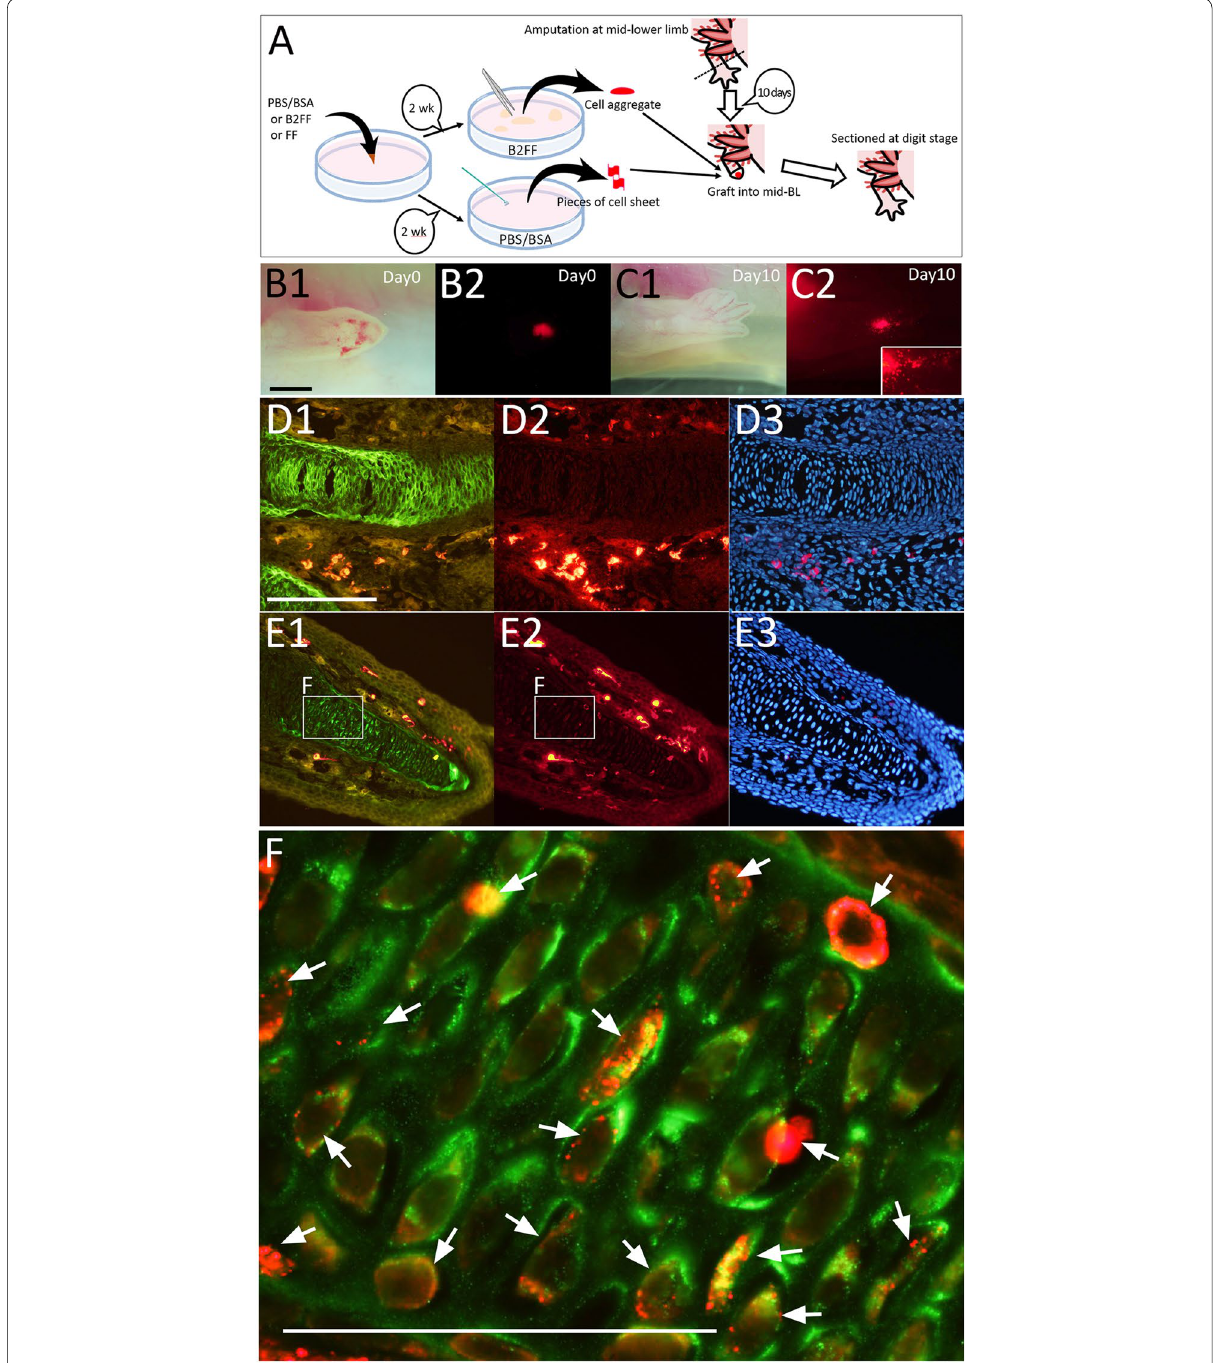
Fig. 2 The cultured newt cells were grafted into regenerating axolotl limb blastema. A The schematic diagram of the experiment. B Just after the grafting. Scale bar in B1 1 mm. C 10 days after the grafting. Newt cells (red) were spread out in the regenerate (insert). D – F The distribution of the = newt cells was investigated on the section. Immunofluorescent analysis for Col2a (green; D1 and E1) and mCherry (red; D2 and E2) was performed. Nuclei were visualized by Hoechst33342 (blue; D3 and E3). F the merged image of the boxed region in E1 and E2. The red signals were observable within the Col2a region. The scales bar in D1 and F are 300 and 100 μm, +